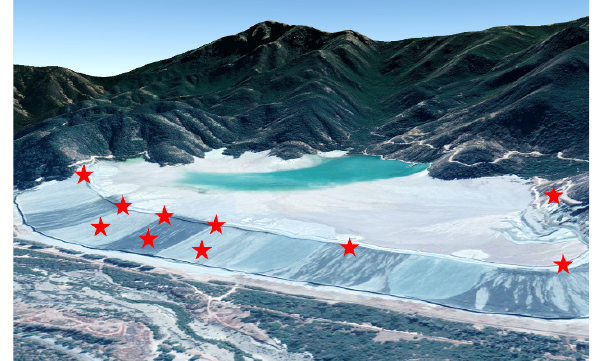
Figure 6. Planned positions (red asterisks) of 10 GNSS